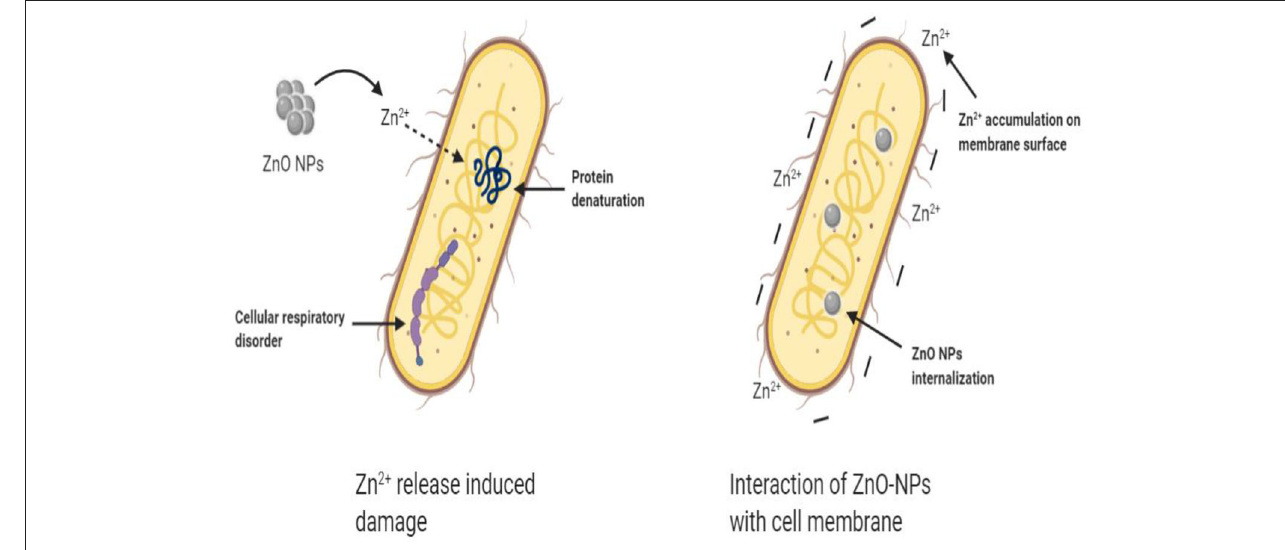
FIGURE 2 | Two other antibacterial mechanisms of ZnO